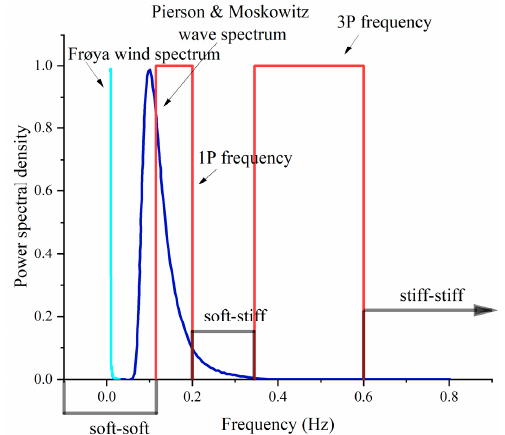
Figure 1. Frequency spectrum of the dynamic loads [4].